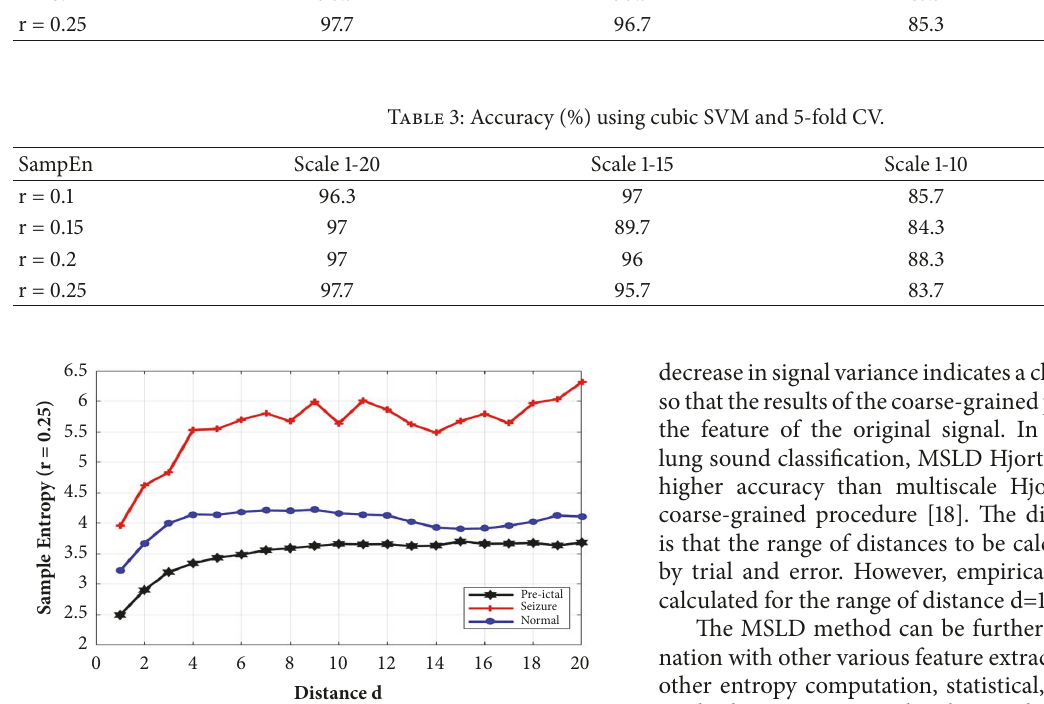
Figure 7: Sample entropy (r = 2.5) with MLSD for each distance